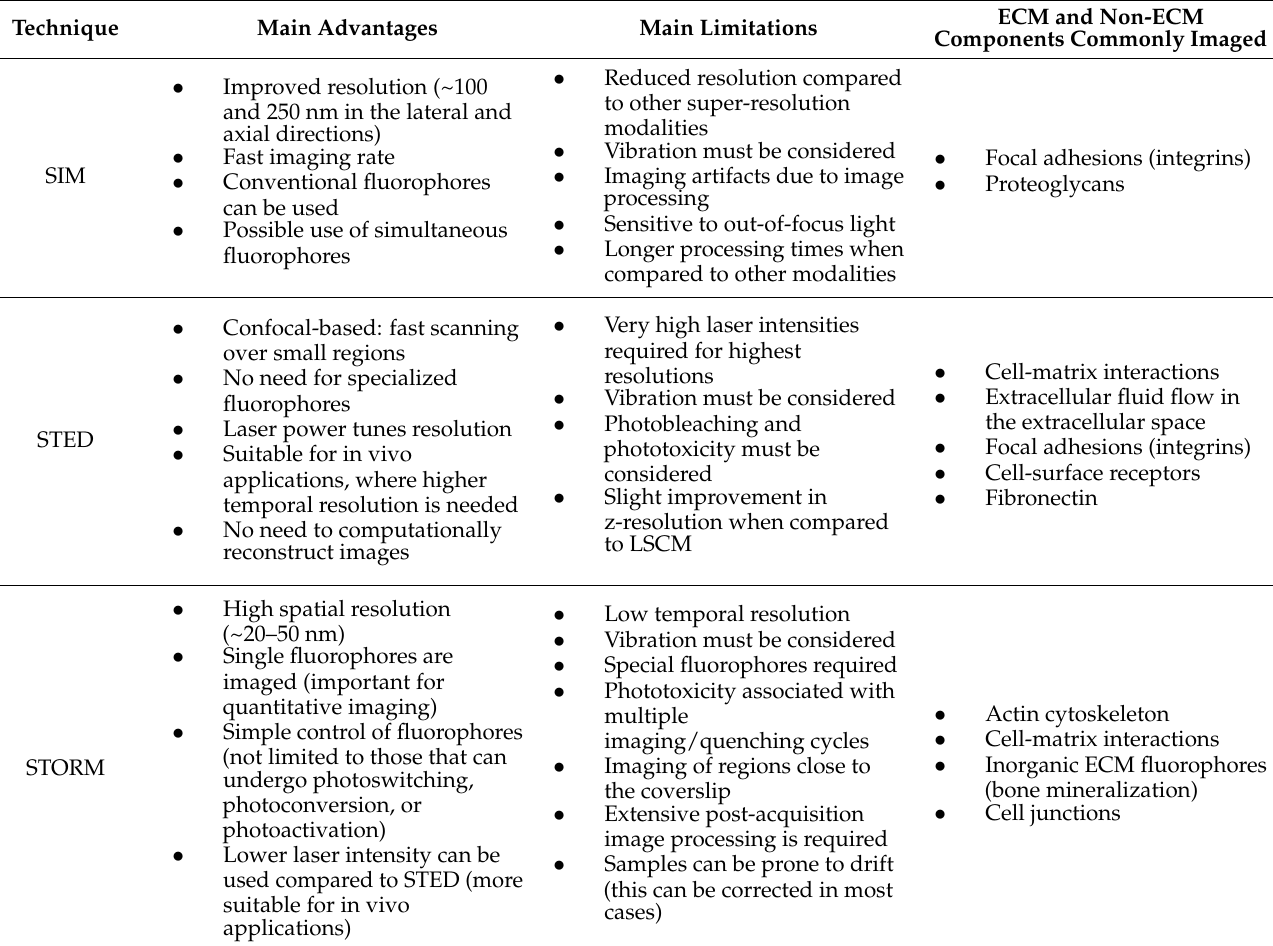
Table 2. The most commonly used linear fluorescence-based super-resolution microscopy modalities to assess ECM components. Technique Main